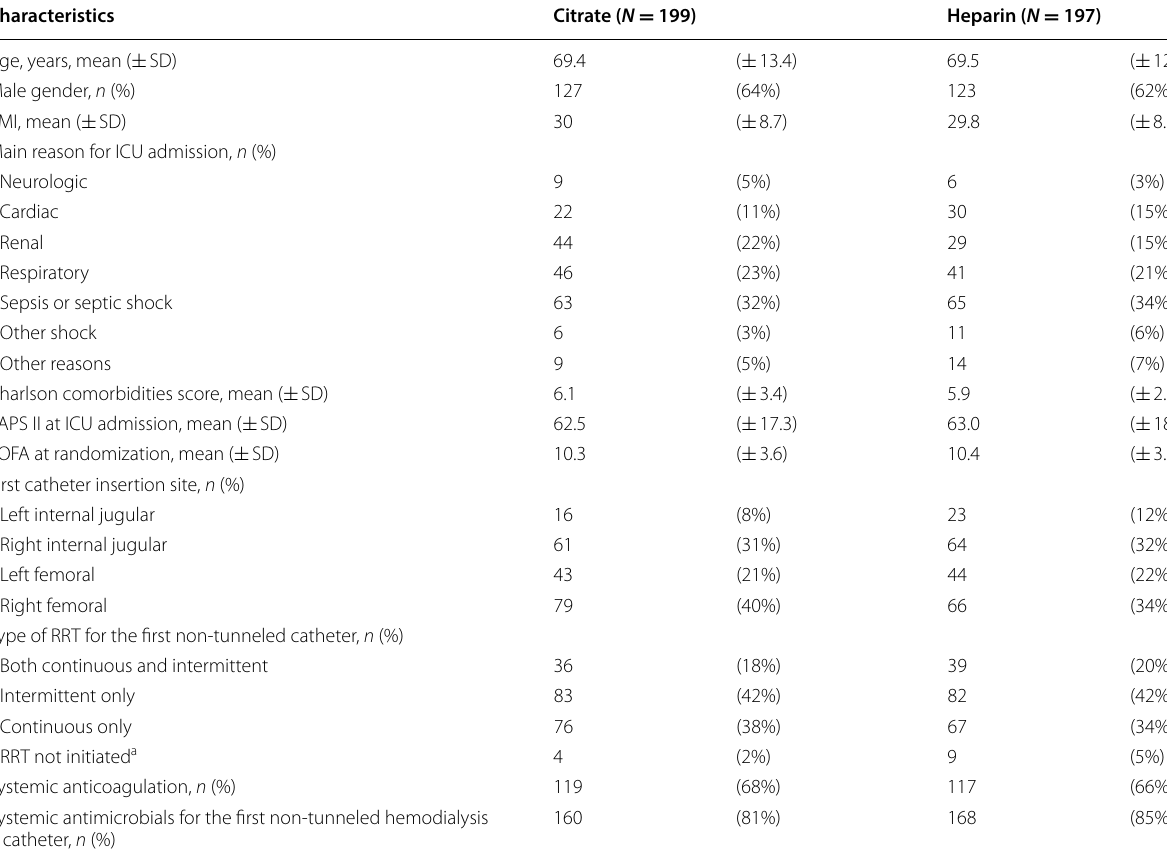
Table 1 Characteristics of the study population of the VERROU-REA study ( N